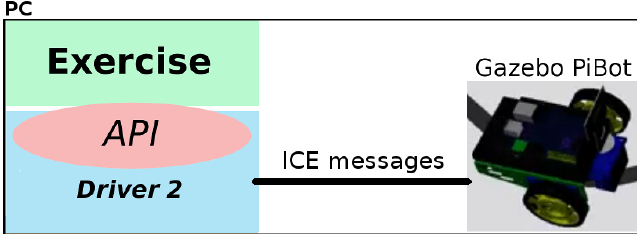
Figure 9. Connection of the library with the simulated PiBot